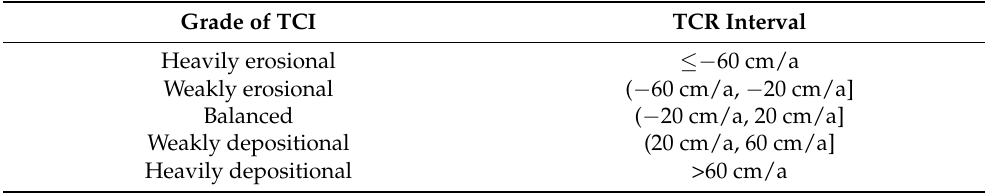
Table 1. Judgement criteria for the different grades of TCI in the Liangsha OIS.